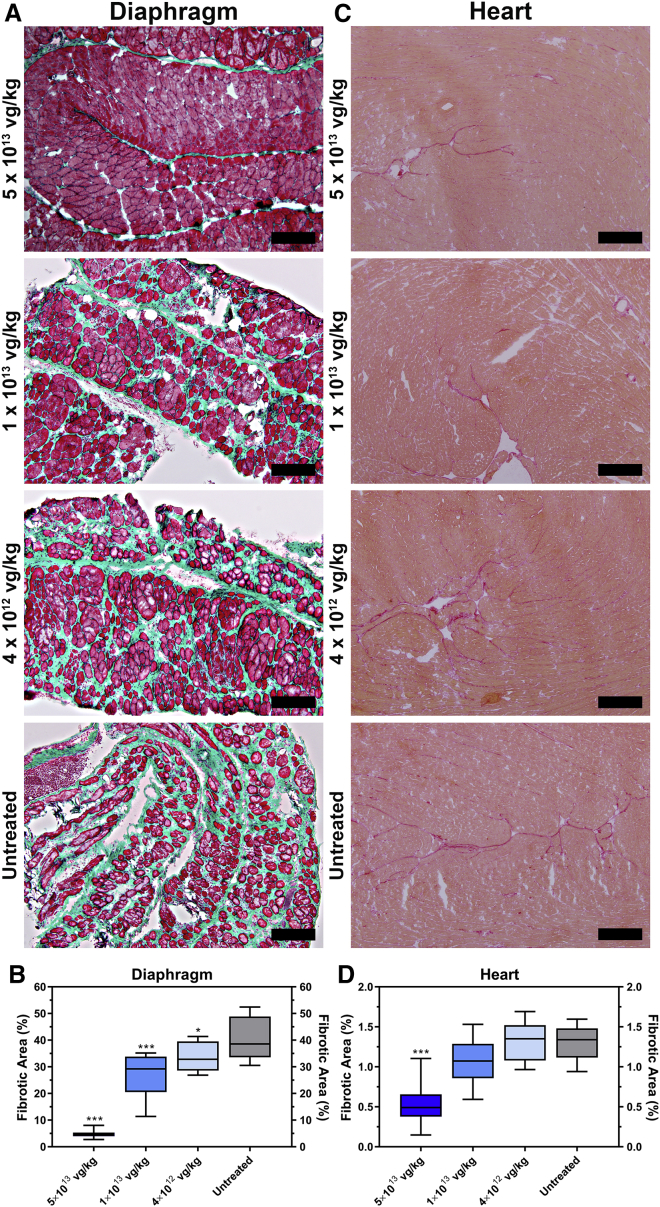
Dose-Dependent Effects of AAV9-FKRP Gene Therapy on the Progression of Fibrosis in the Diaphragm and Heart(A) Masson’s trichrome-stained cross-sections of the diaphragm and (C) picrosirius red stained myocardial cross-sections from 52-week-old AAV9-FKRP-treated (5 × 1013, 1 × 1013, 4 × 1012 vg/kg) and untreated FKRPP448L mice. Scale bars, 200 μm. Quantification of the fibrotic area in the (B) diaphragm and (D) heart from AAV9-FKRP-treated (5 × 1013, 1 × 1013, 4 × 1012 vg/kg) and untreated FKRPP448L cohorts (n = 10). Box-and-whisker plots with Tukey whiskers. *p ≤ 0.05, ***p ≤ 0.001, one-way ANOVA, Dunnett’s test with each condition versus age-matched untreated FKRPP448L mice.